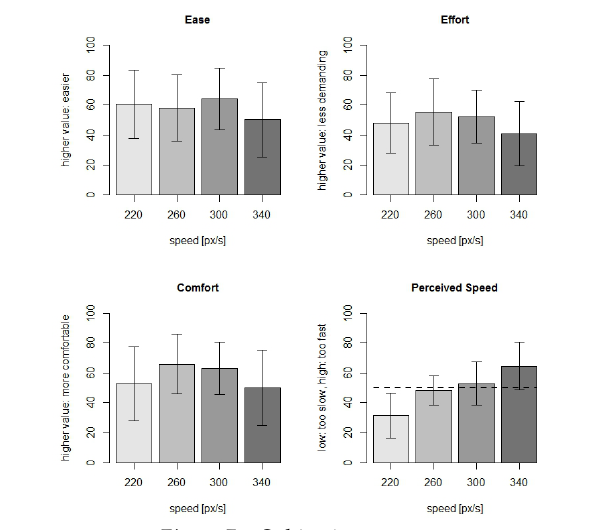
Figure 6 . Performance results Figure 7 . Subjective